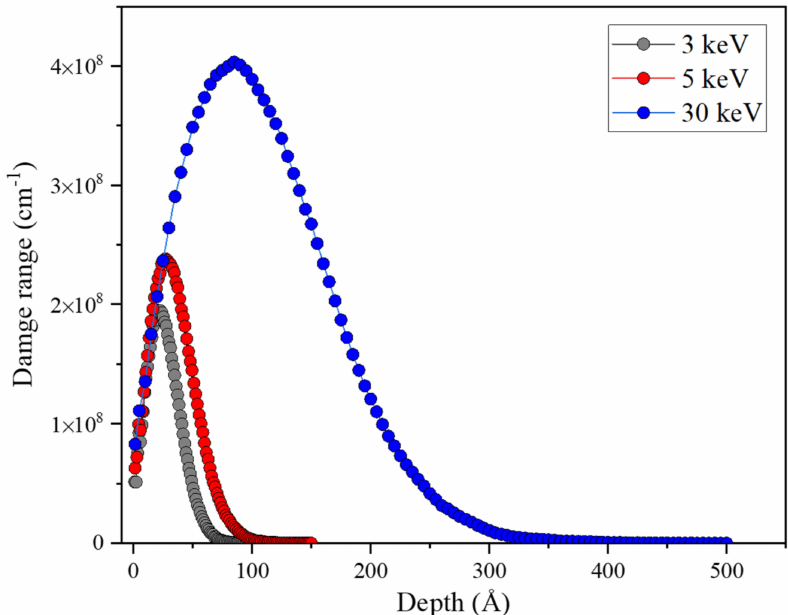
Figure 6. SRIM results for Ga ion induced recoil damage distribution in Al/Ni substrate under different ion energies.